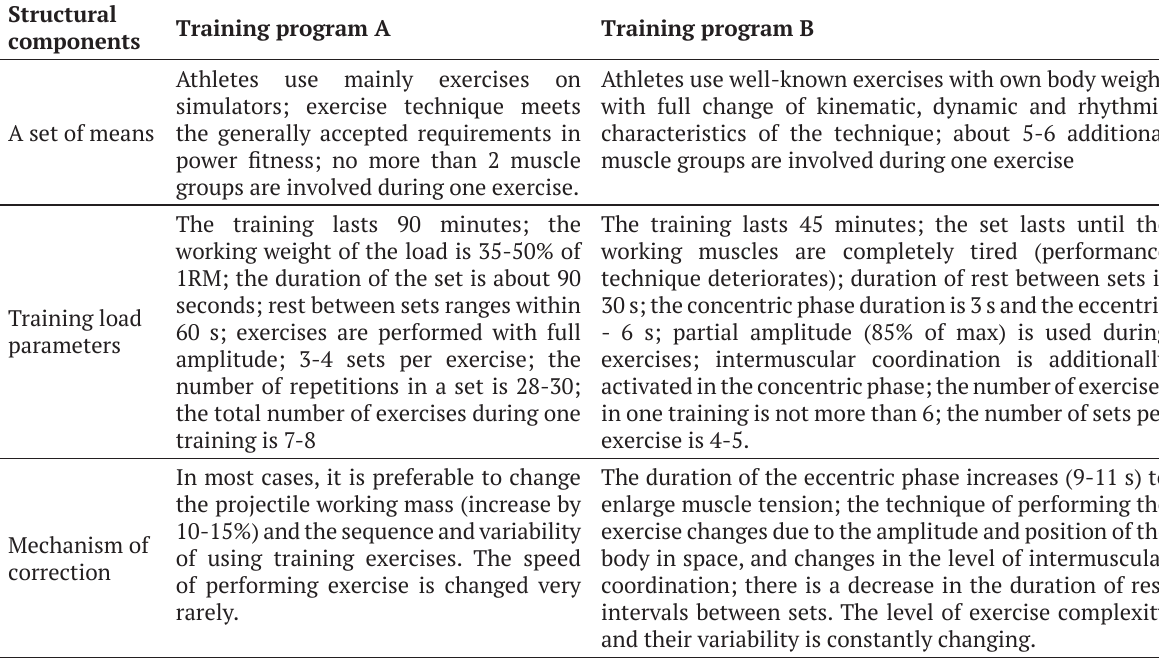
Table 1. Power fitness training programs used by athletes during the